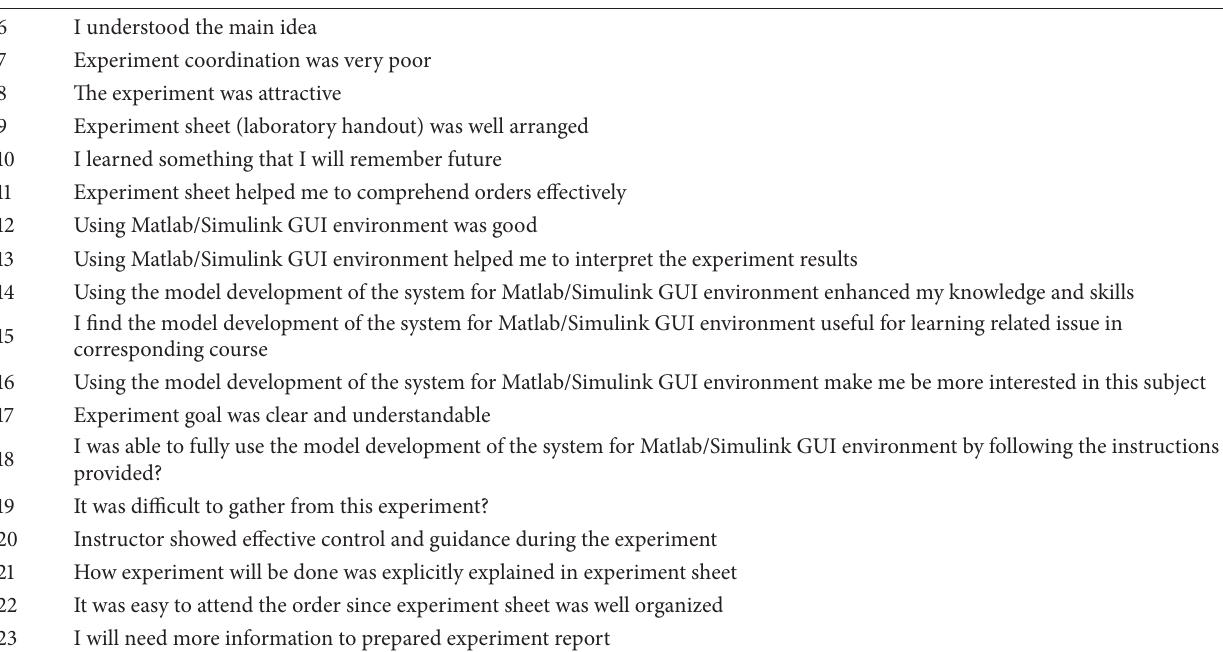
Table 6: Assessment data student evaluations using a Likert-scale